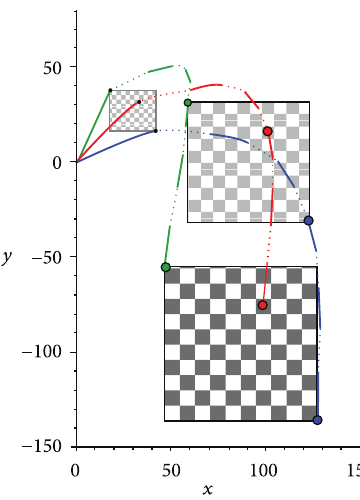
Figure 4: The trajectory of a textured quad.